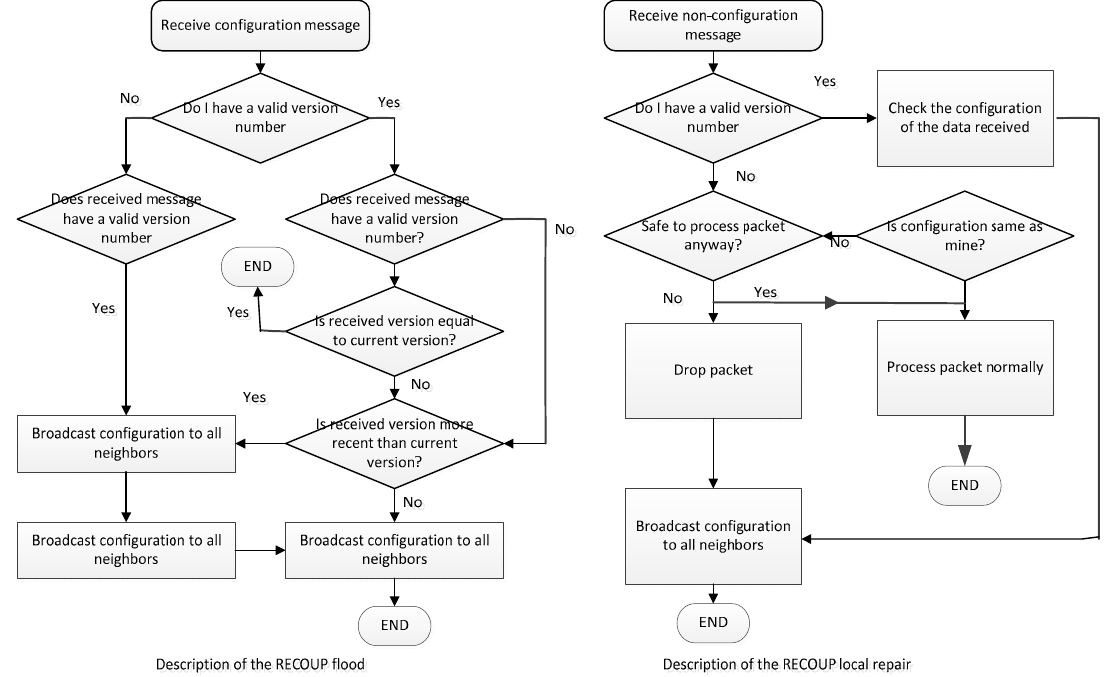
Figure 17. Flooding and local repair processes of the REGROUP